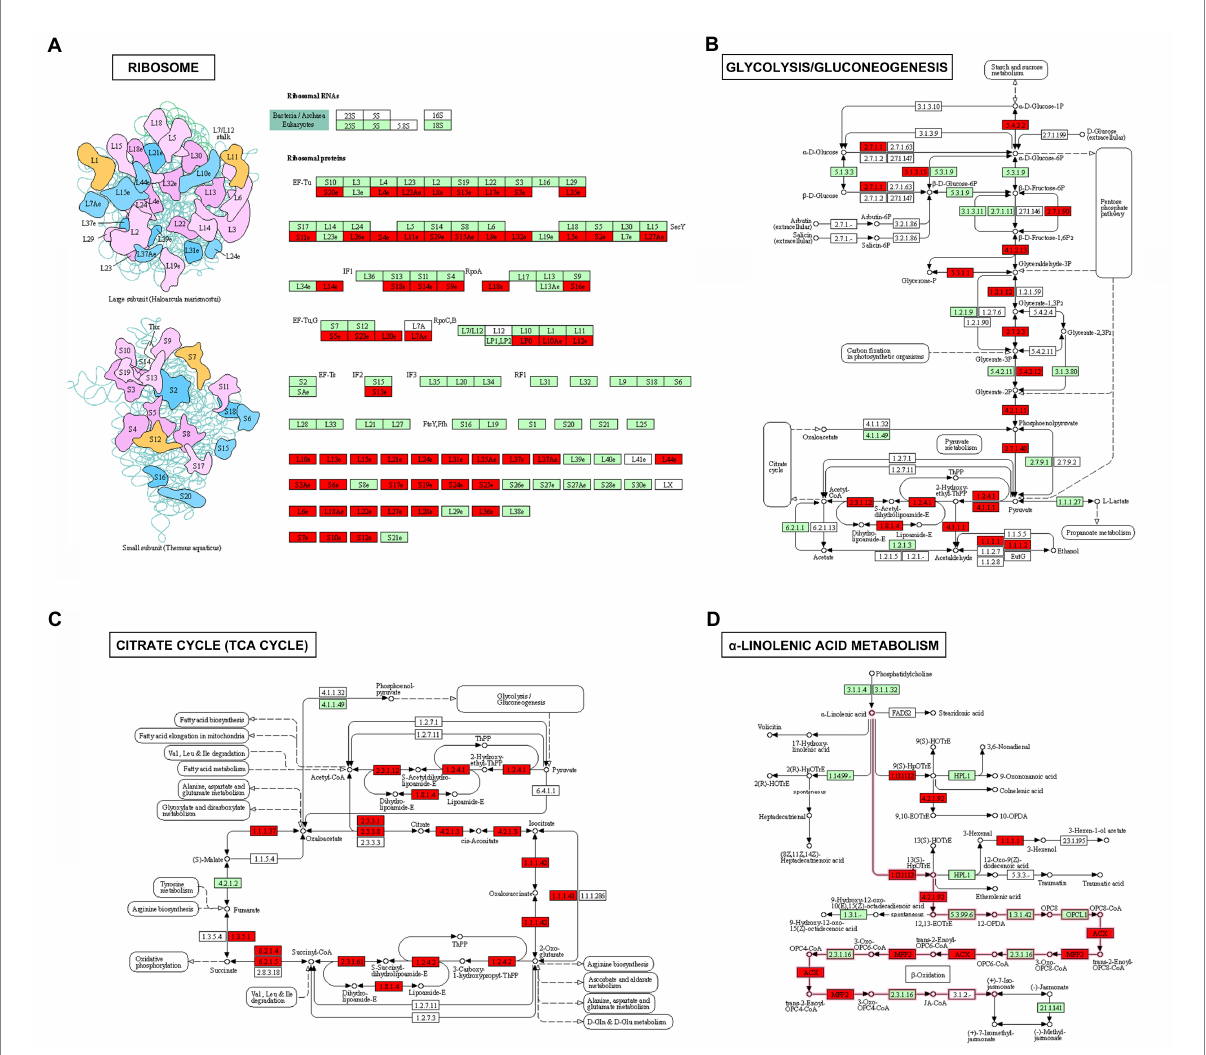
FIGURE 6 Upregulated Khib-modified proteins enriched in ribosome (A) , glycolysis/gluconeogenesis (B) , TCA cycle (C) , and alpha-linolenic acid metabolism (D) in maize. Green represents the enzyme or protein of maize in this KEGG pathway and the 2-hydroxyisobutyrylated enzymes or proteins identified are highlighted in